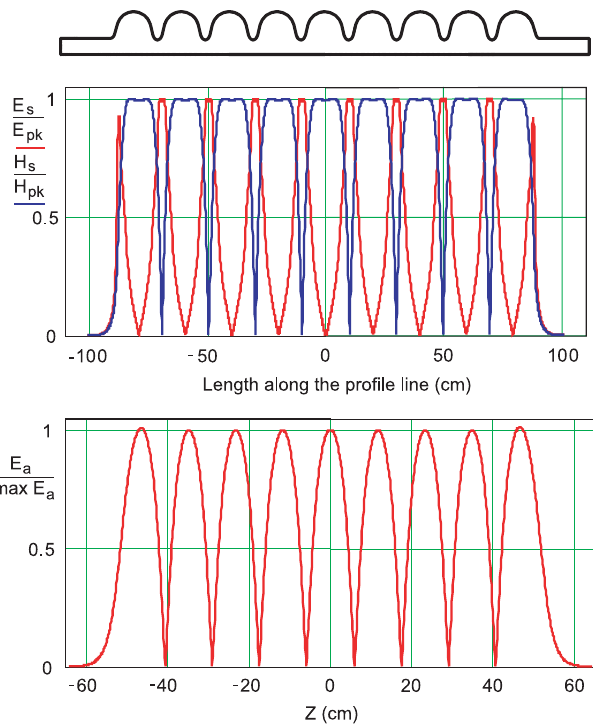
FIG. 18. (Color) Geometry, fields along the profile line, and electric field on the axis of the TESLA